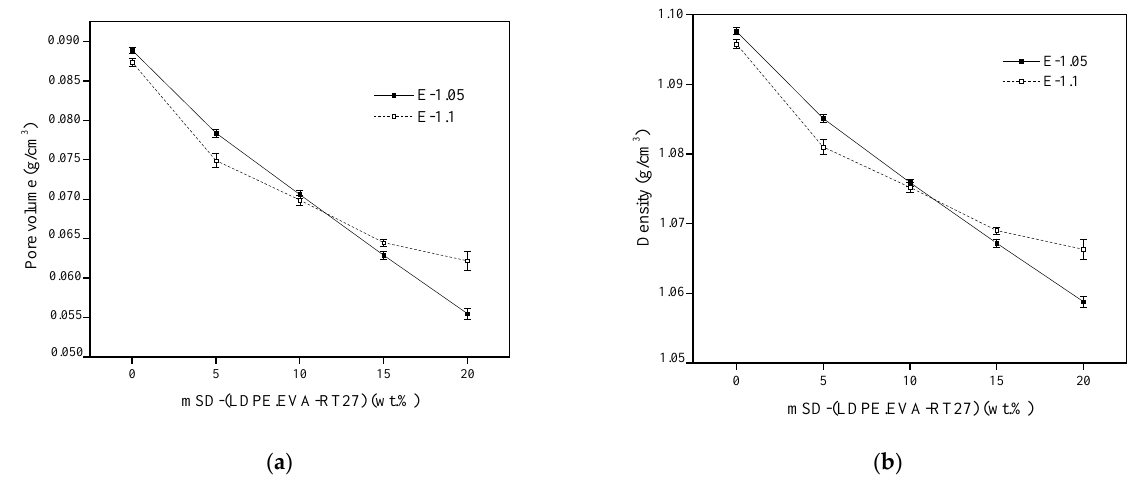
Figure 5. Porosity ( a ) and density ( b ) of the elastomers with different mSD-(LDPE·EVA-RT27) contents and [NCO]/[OH] molar ratios.